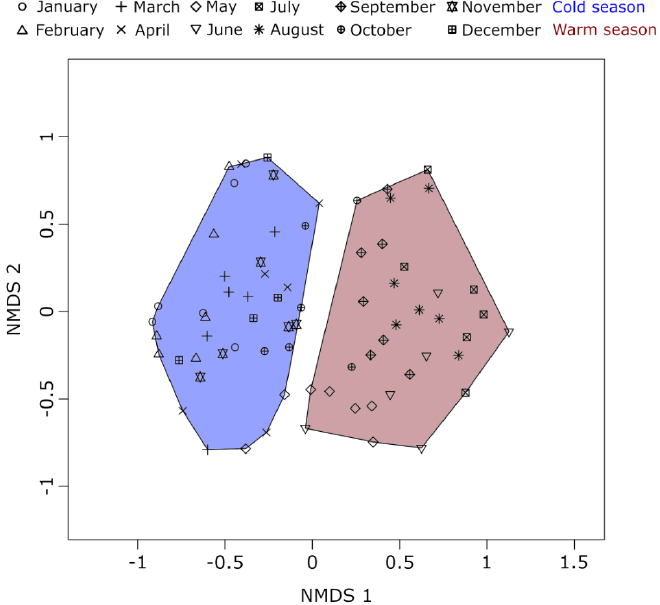
Figure 2. Non-metric multidimensional scaling of time-series data. The scaling is based on Bray–Curtis dissimilarity values of metabarcoding community data between each pair of samples. Each symbol represents a different month of sampling and each sample was classified into either cold season ( blue ) or warm-season ( red ). With few exceptions, samples from October to April were classified as cold season and samples from May to September as the warm season. The stress for the scaling was 0.1826. Table 2. Key properties of the co-occurrence networks in both seasons.